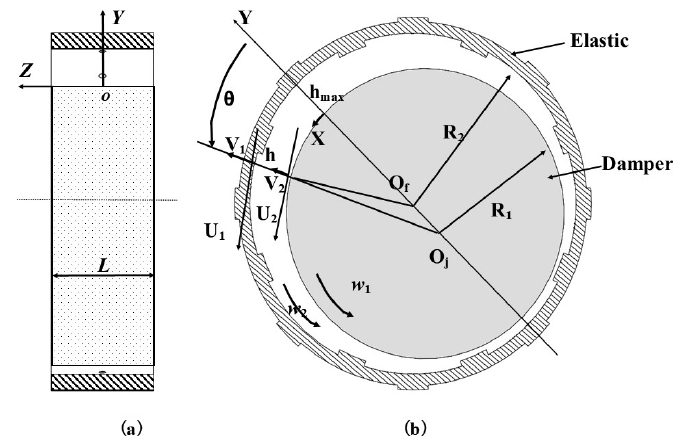
Figure 2. Motion State of ERSFD. ( a ) Elevation view. ( b ) Motion state of the inner oil